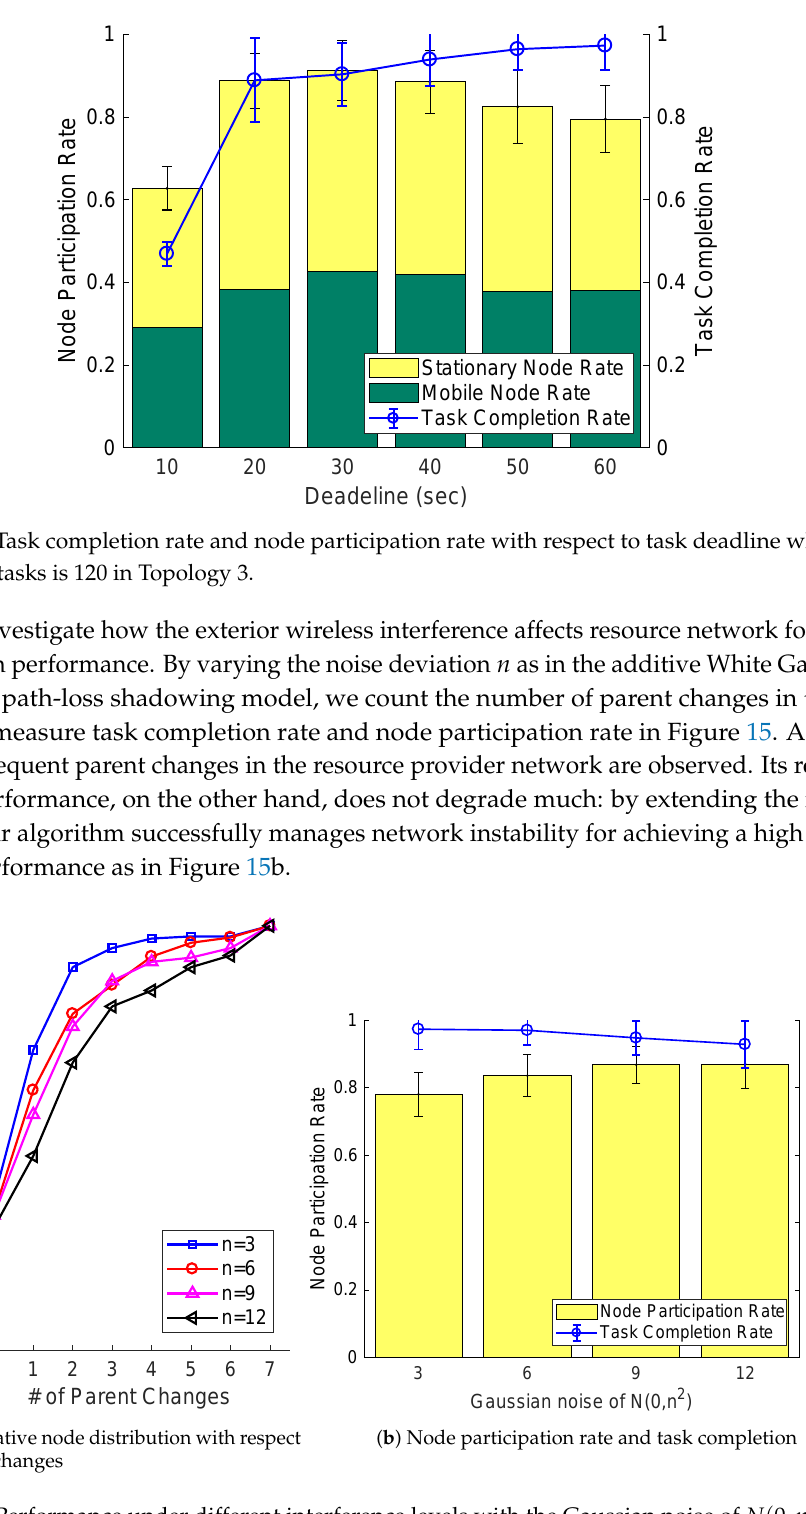
Figure 15. Performance under different interference levels with the Gaussian noise of N ( 0, n 2 ) in dB where the number of tasks is 120 in Topology